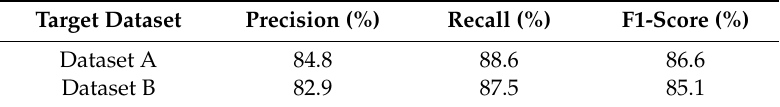
Table 2. Results of two target datasets with Scenario 1.